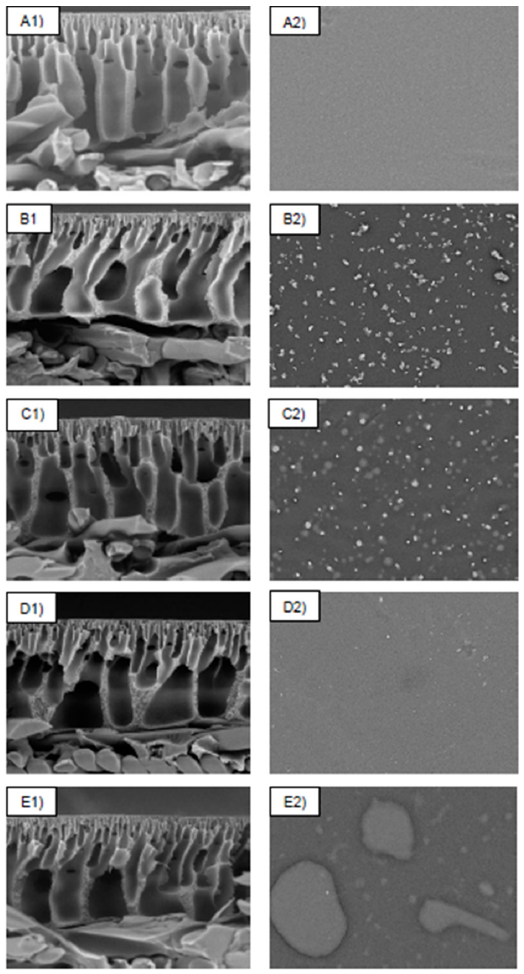
Figure 2. Surface and cross-sectional morphologies of ( A ) PSf, ( B ) PSf-PDA, ( C ) M-ZPEI 1.0, ( D ) M-ZPEI 2.0, and ( E ) M-ZPEI 3.0 with magnification of 1 k (cross-sectional, 50 µm scale) and 1.2 k (surface, 100 µm scale).